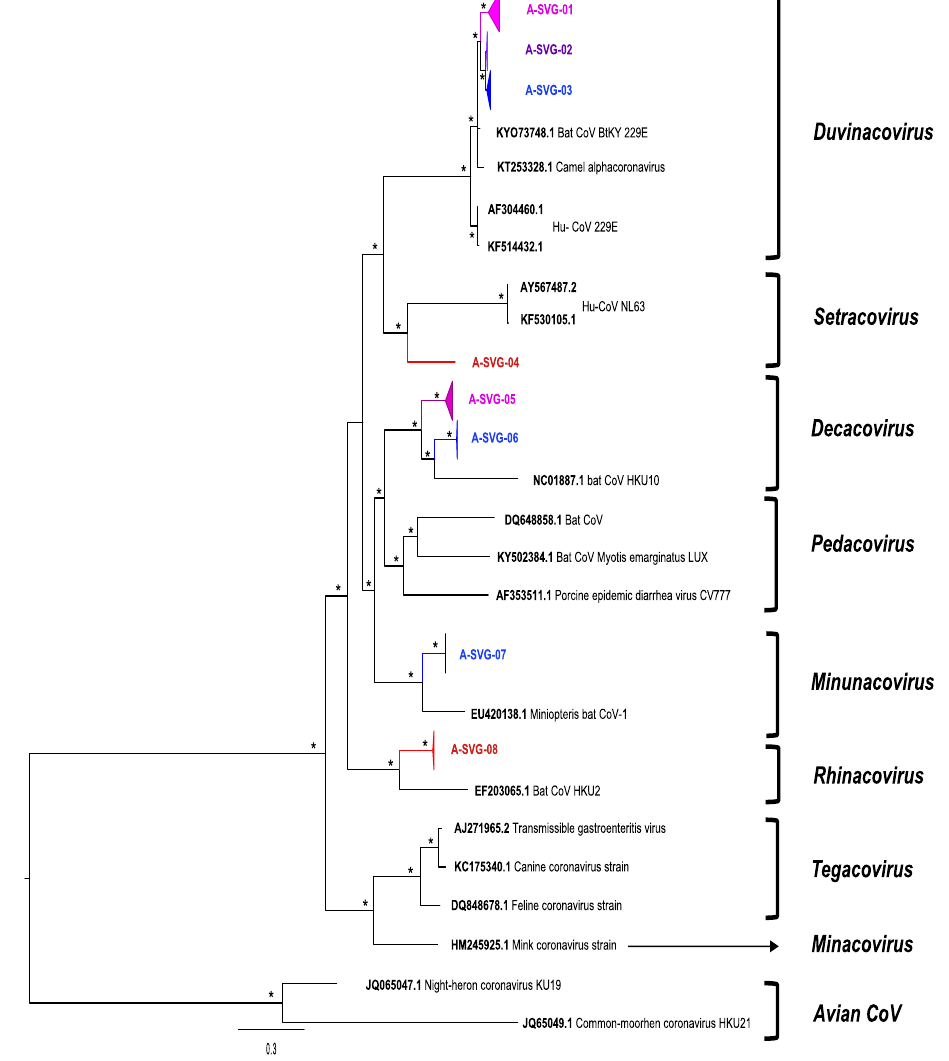
Figure 3. Phylogenetic tree of AlphaCoV partial RdRp gene. The sequences detected at Chirundu site are in red color and from Magweto site in blue color. Pink = more sequences detected at Chirundu than Magweto within the same subclade and purple = more sequences detected at Magweto site than Chirundu site within the subclade. The tree was built using the maximum likelihood method based on the GTR + G4 + I model. The robustness of nodes was assessed with 1000 bootstrap replicates. Bootstrap values >70 are denoted with asterisks, and those <70 are not shown.